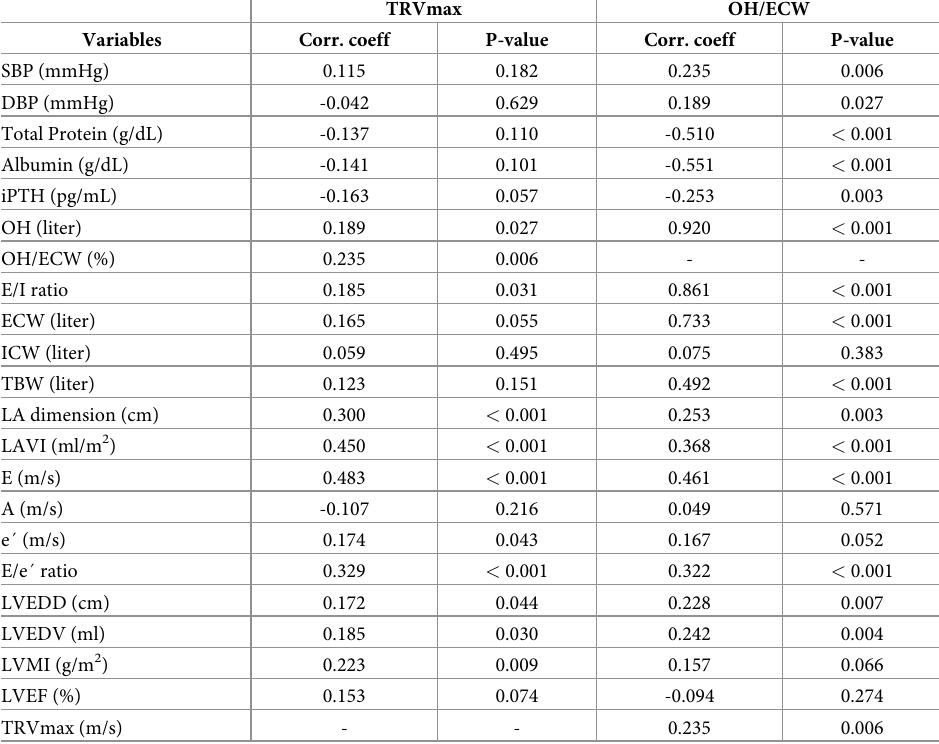
Table 3. Correlation between laboratory, echocardiographic parameters and markers of volume status.